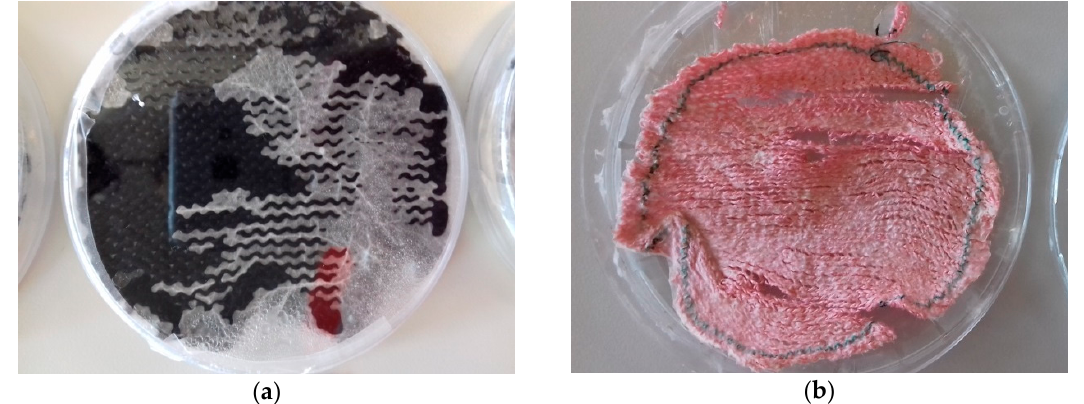
Figure 8. Mycelium after finished experiments: ( a ) rear side of cotton fabric before drying; ( b ) dried acrylic/wool sample.